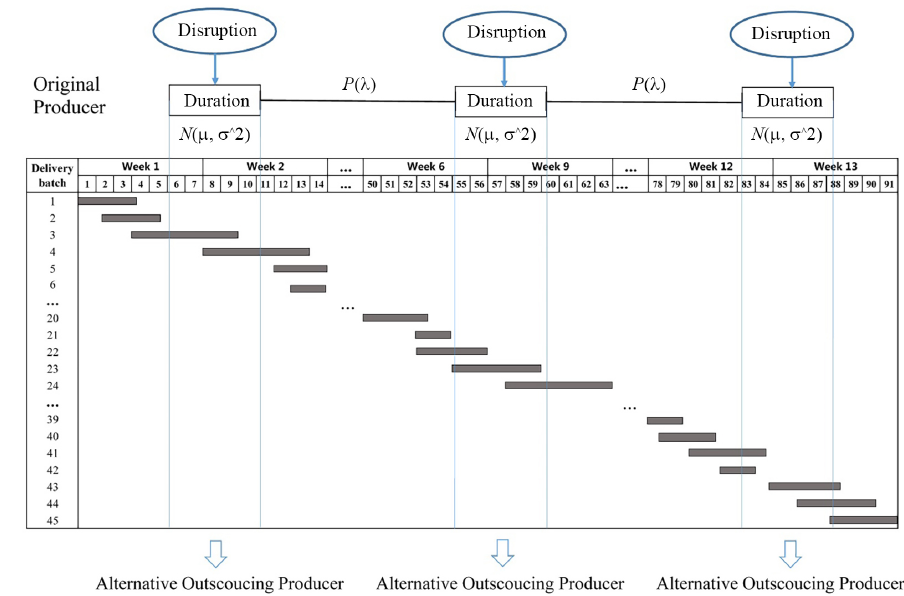
Figure 5. Disruptions on supply of the components at the production